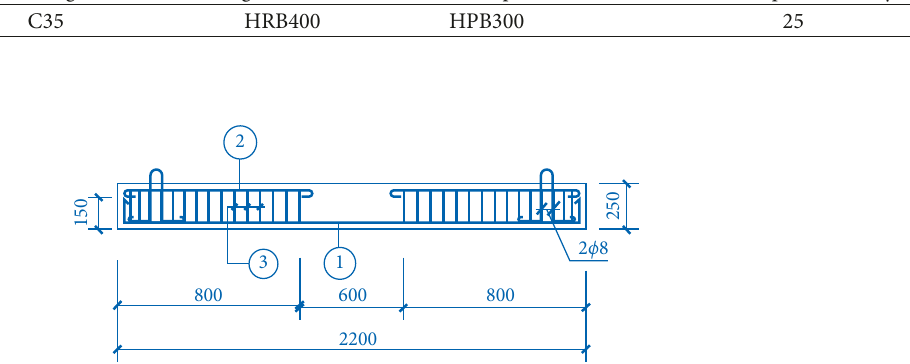
Figure 2: Reinforcement of reinforced concrete beams.